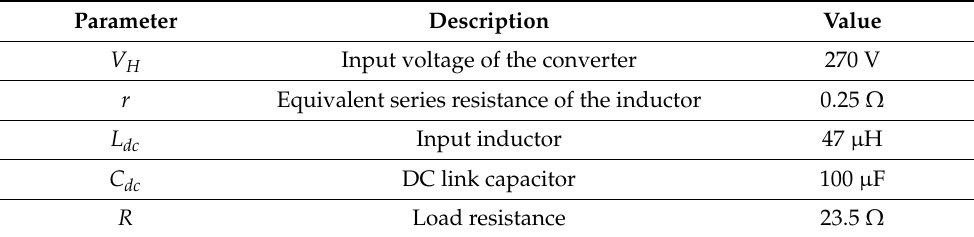
Table 2. Nominal values of the parameters in the EMA emulator. Parameter Description Value V H Input voltage of the converter 270 V r Equivalent series resistance of the inductor 0.25 Ω L dc Input inductor 47 µ H C dc DC link capacitor 100 µ F R Load resistance 23.5